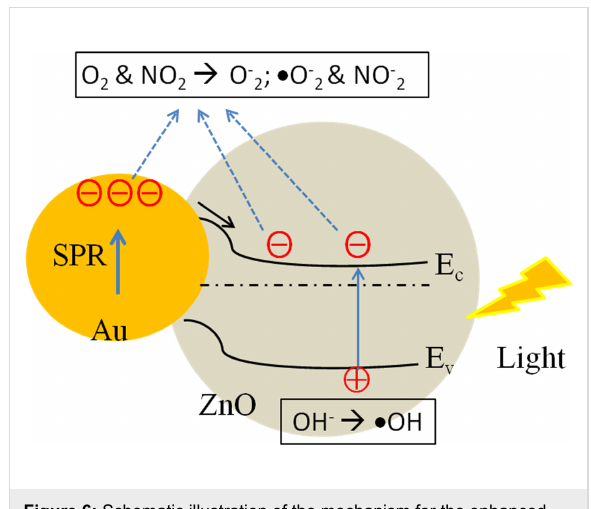
Figure 6: Schematic illustration of the mechanism for the enhanced gas sensing and photoactivity reported for the Au nanoparticle/ZnO structures in this